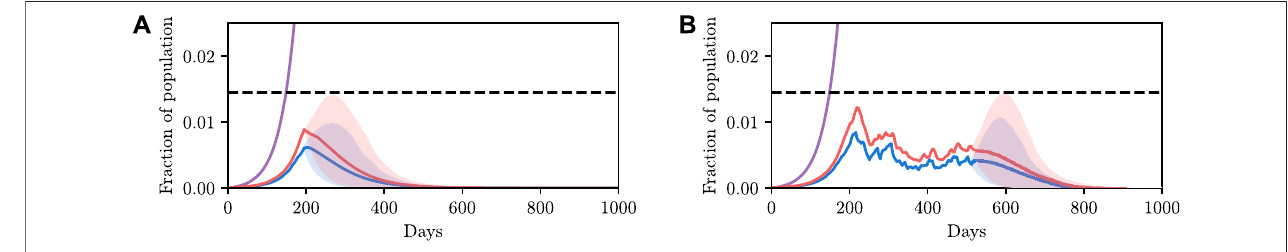
FIGURE 6 | Here we brie fl y demonstrate the capacity of the SEI 3 R model in a model predictive control setting. (A) shows the state when we begin controlling the systemat t (cid:1) 200withsomelevelofinfectionalreadypresent.Wesolvefortheminimumrequiredcontrolsuchthattheconstraintissatis fi ed.Weplotthe90 % con fi